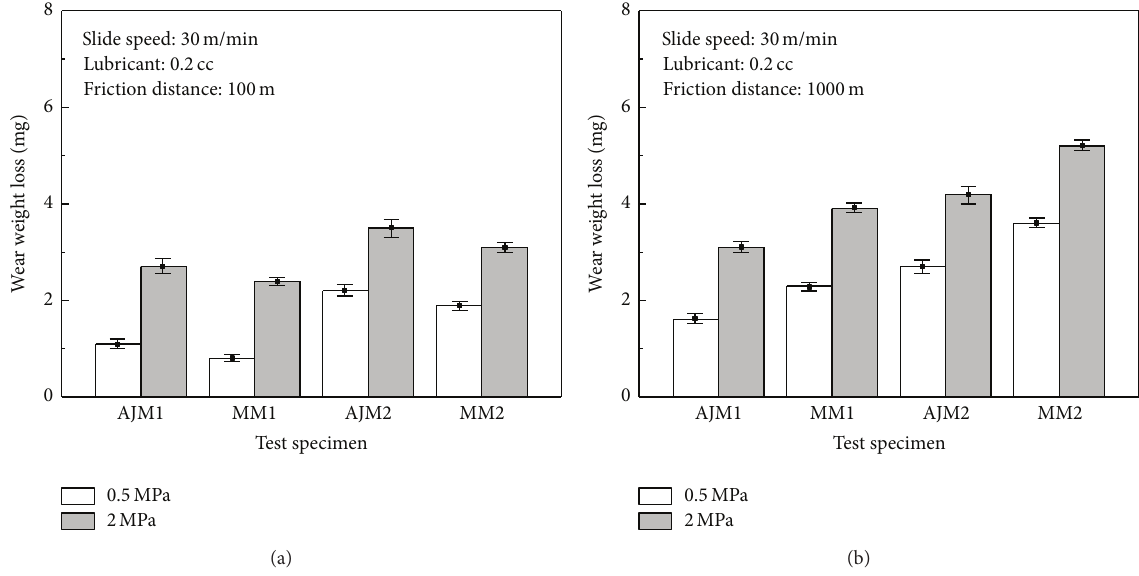
Figure 7: Comparison of loads and wear amounts under friction distances (a) 100 m, (b)